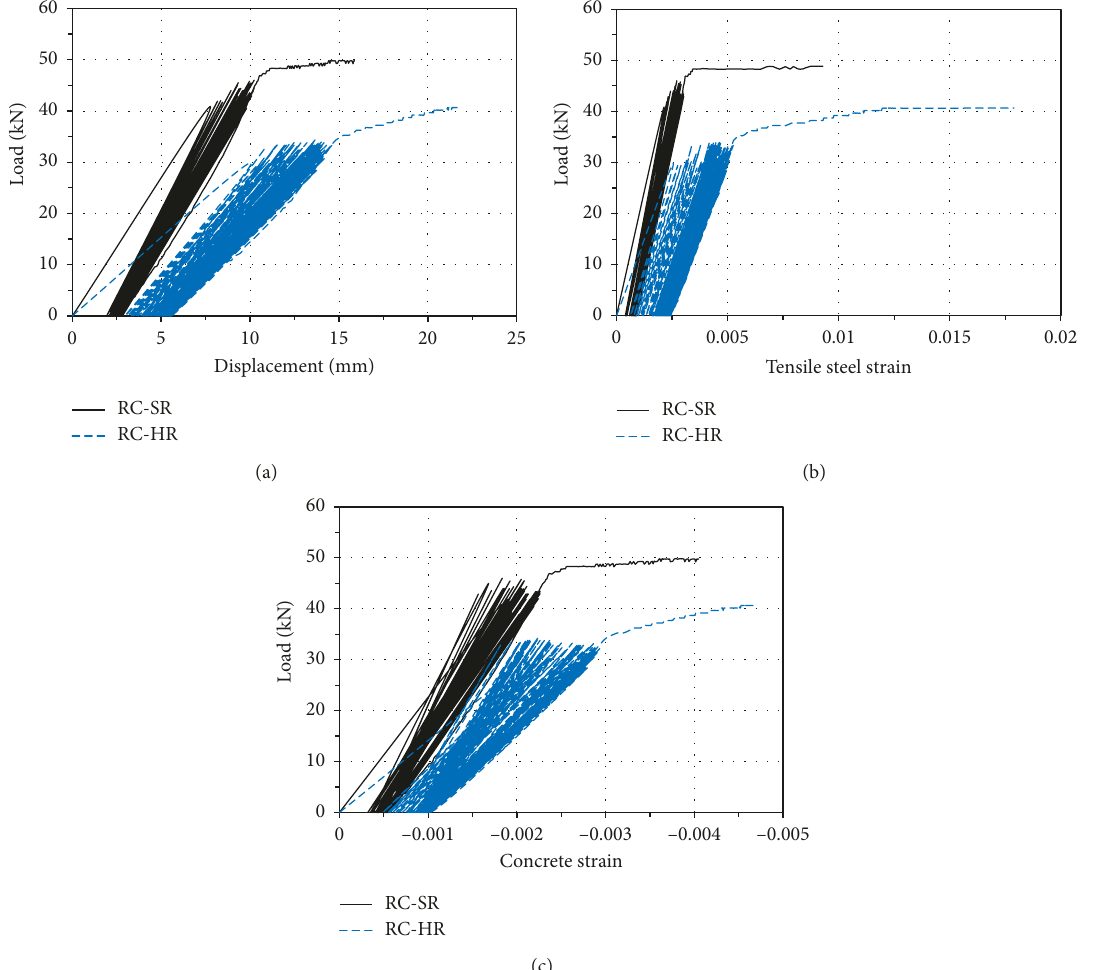
Figure 9: Comparison of fatigue test results of RC beam specimens reinforced by the steel rebar (RC-SR) and by the hybrid FRP-steel rebar (RC-HR): (a) fatigue load-deflection curves measured at midspan [25]; (b) fatigue load-tensile strain curves measured in longitudinal reinforcement; (c) fatigue load-concrete compressive strain